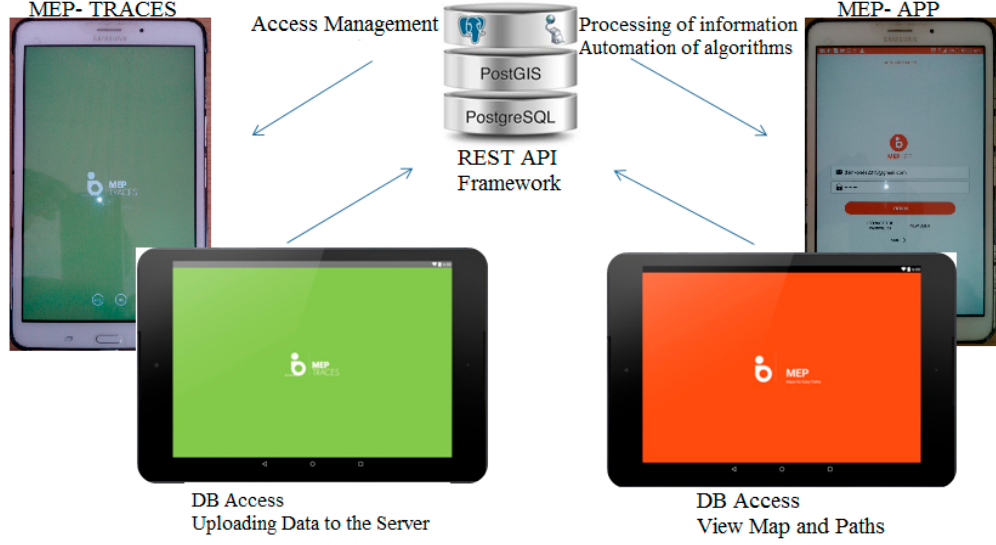
Figure 6. Identification of relationships of MEP system architecture.